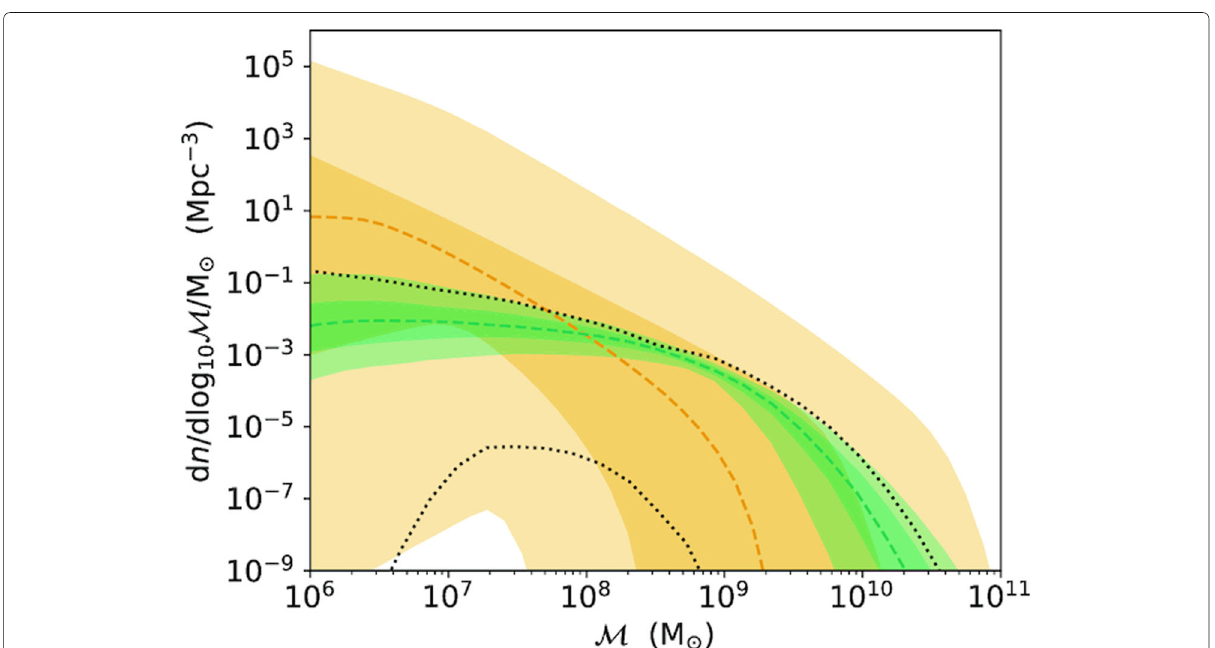
Fig. 6 The redshift-integrated mass function of the chirp mass M c = M of SMBHs inferred from 12.5-year NANOGrav observation. Dark and light orange (green) regions represent 50 and 90% credible regions of M16 (C19) models. Taken from Fig. 3 of “Massive black hole binary systems and the NANOGrav 12.5-year results”